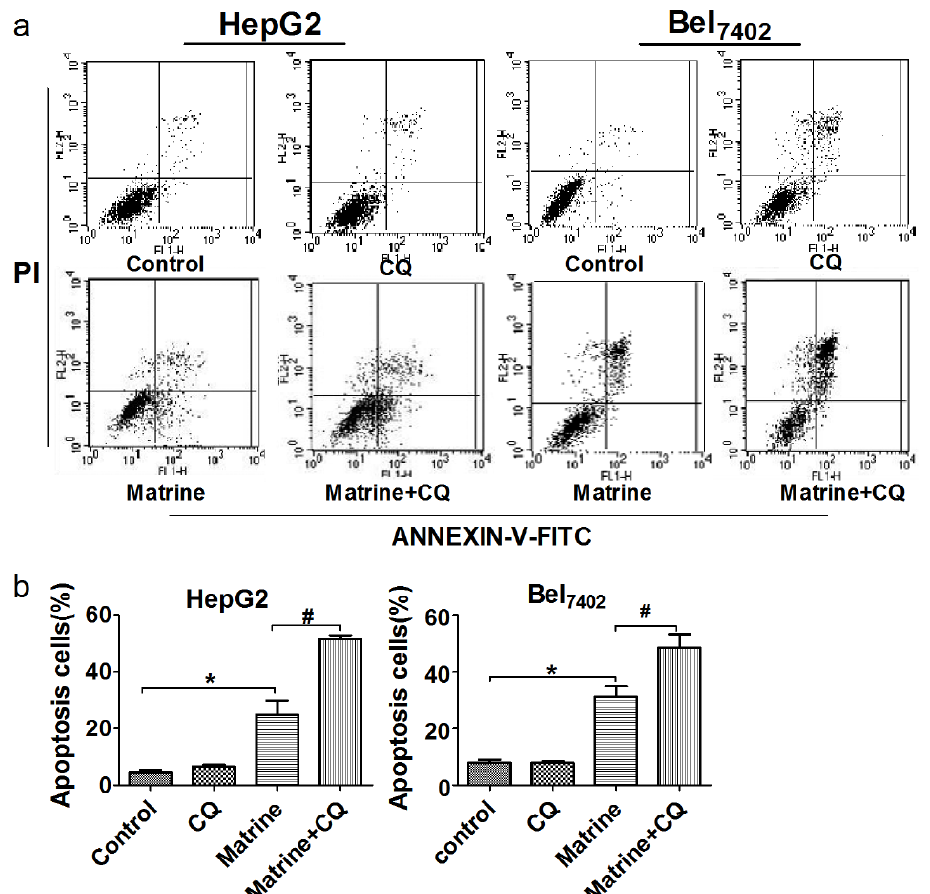
apoptosis. ( a ) HepG2 and Bel cells were treated with matrine 0.8 mg/mL in the absence 7402 or presence of CQ (7.8 µM) for 48 h. Annexin V-FITC and PI double-staining shows the percentages of early (bottom right) and late (top right) apoptotic cells; ( b ) Analysis of the total percentage of early and late apoptotic cells in different groups; ( c ) Western blot cells treated analysis of activated caspase-3, -8, and -9 expression in HepG2 and Bel 7402 with 0.8 mg/mL matrine in the absence or presence of CQ (7.8 µM) for 48 h. β -Actin is shown as a loading control; ( d ) Analysis of relative expression of activated caspase-3, -8, and -9; ( e ) Activity of caspase-3, -8, -9 in HepG2 and Bel cells after treated with 7402 matrine 0.8 mg/mL in the absence or presence of CQ. Data are from three independent experiments. * p < 0.05 vs . control group, # p < 0.05 vs . matrine-treated